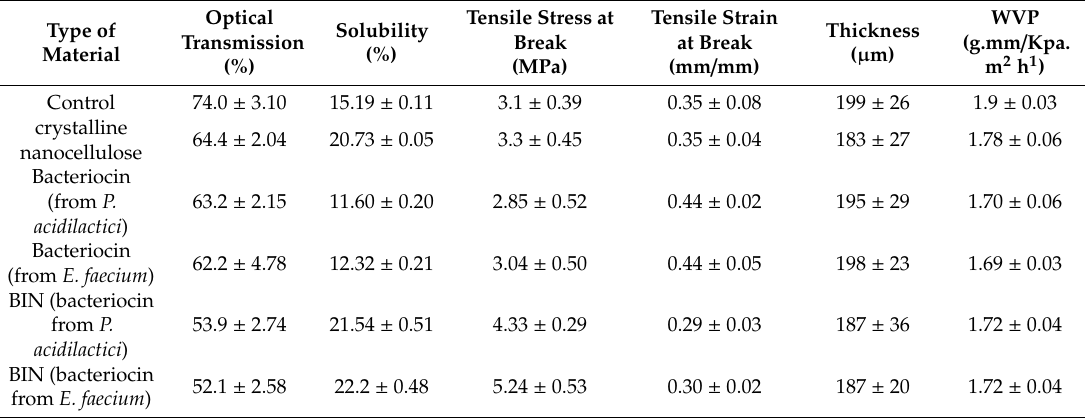
Table 3. Mechanical properties and optical properties of microbial synthesized starch films